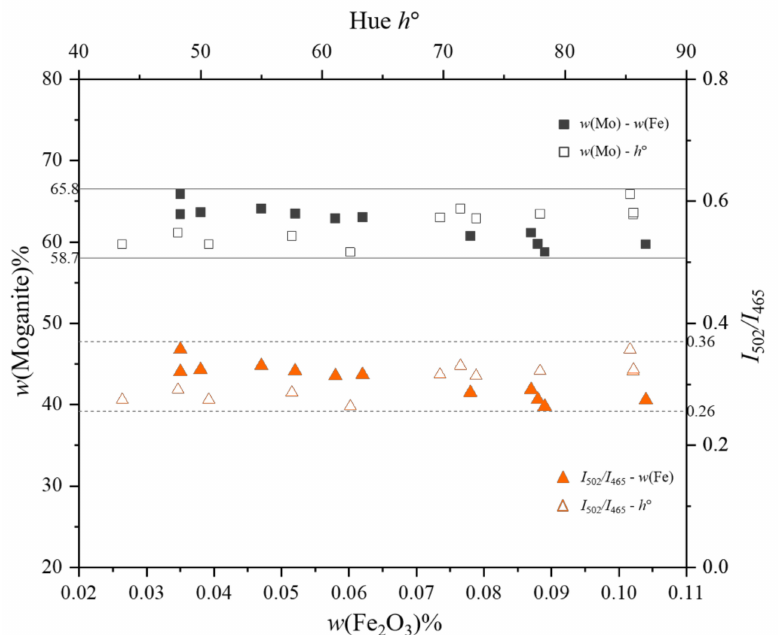
Figure 5. Moganite content and Raman band integral ratio I 502 / I 465 in samples with different total Fe contents and hue angles.